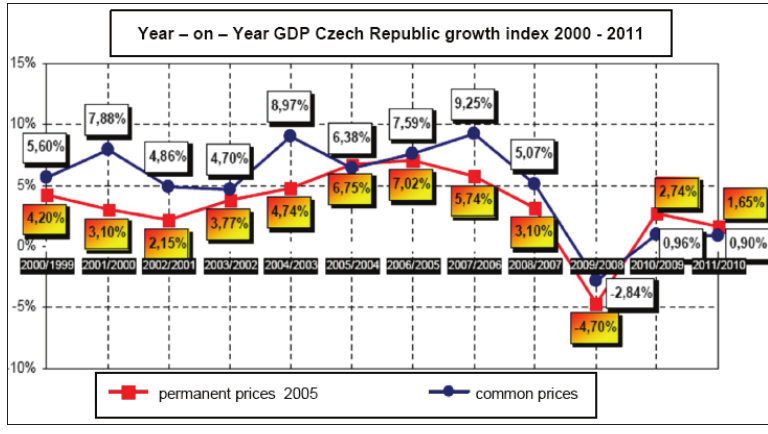
Fig. 2 – The GDP of the Czech Republic, 2000 – 2011 Year-on-Year. Source: AutoSAP,